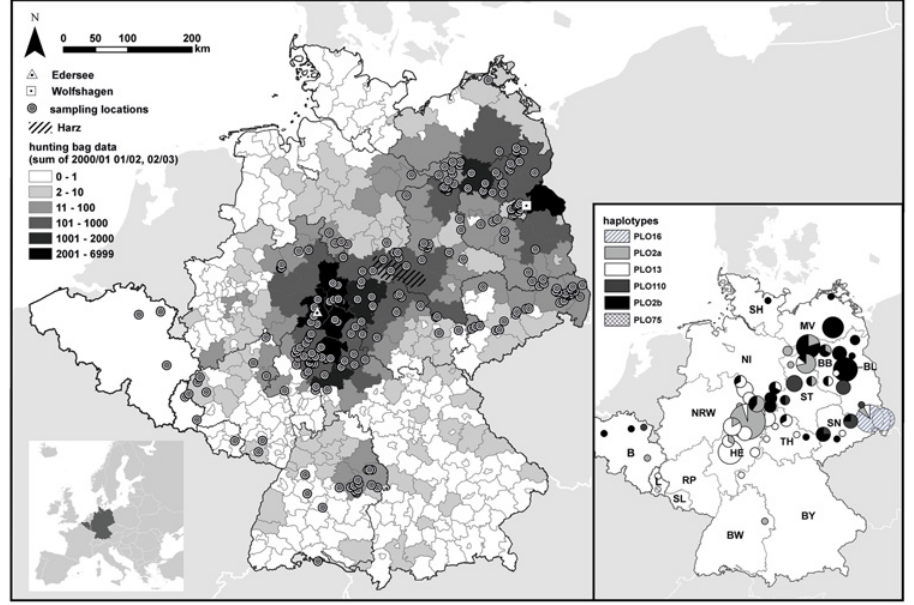
Fig 1. Geographic origin of the 407 raccoon samples used in the present study. One point can represent multiple samples. Hunting bag data: the number of individuals harvested between 2000/01 and 2002/03 in German administrative districts (light grey lines). Inset: mtDNA haplotype frequency distribution of a subset of 193 of the 407 raccoons [19]. Size of the pies corresponds to the number of samples in the administrative districts. Samples were collected in 14 of the 16 federal states in Germany: Brandenburg (BB), Berlin (BL), Baden-Württemberg (BW), Bavaria (BY), Hesse (HE), Mecklenburg-West Pomerania (MV), Lower Saxony (NI), North Rhine-Westphalia (NRW), Rhineland-Palatinate (RP), Schleswig-Holstein (SH), Saarland (SL), Saxony (SN), Saxony-Anhalt (ST) and Thuringia (TH). The inset also shows the location of Belgium (B) and Luxembourg